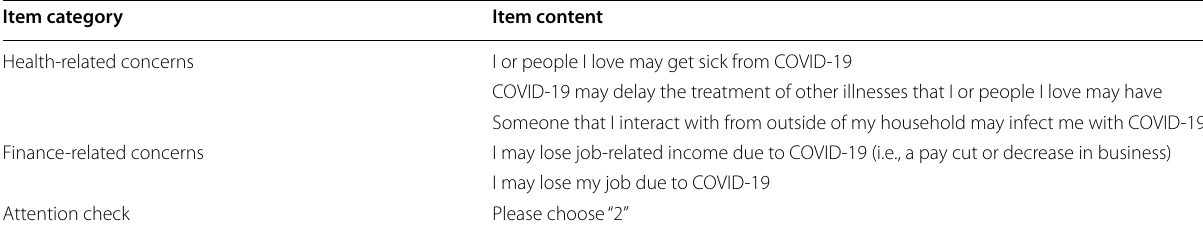
Table 1 Survey items used to assess current concerns. Ratings were obtained on a 7-point scale Item